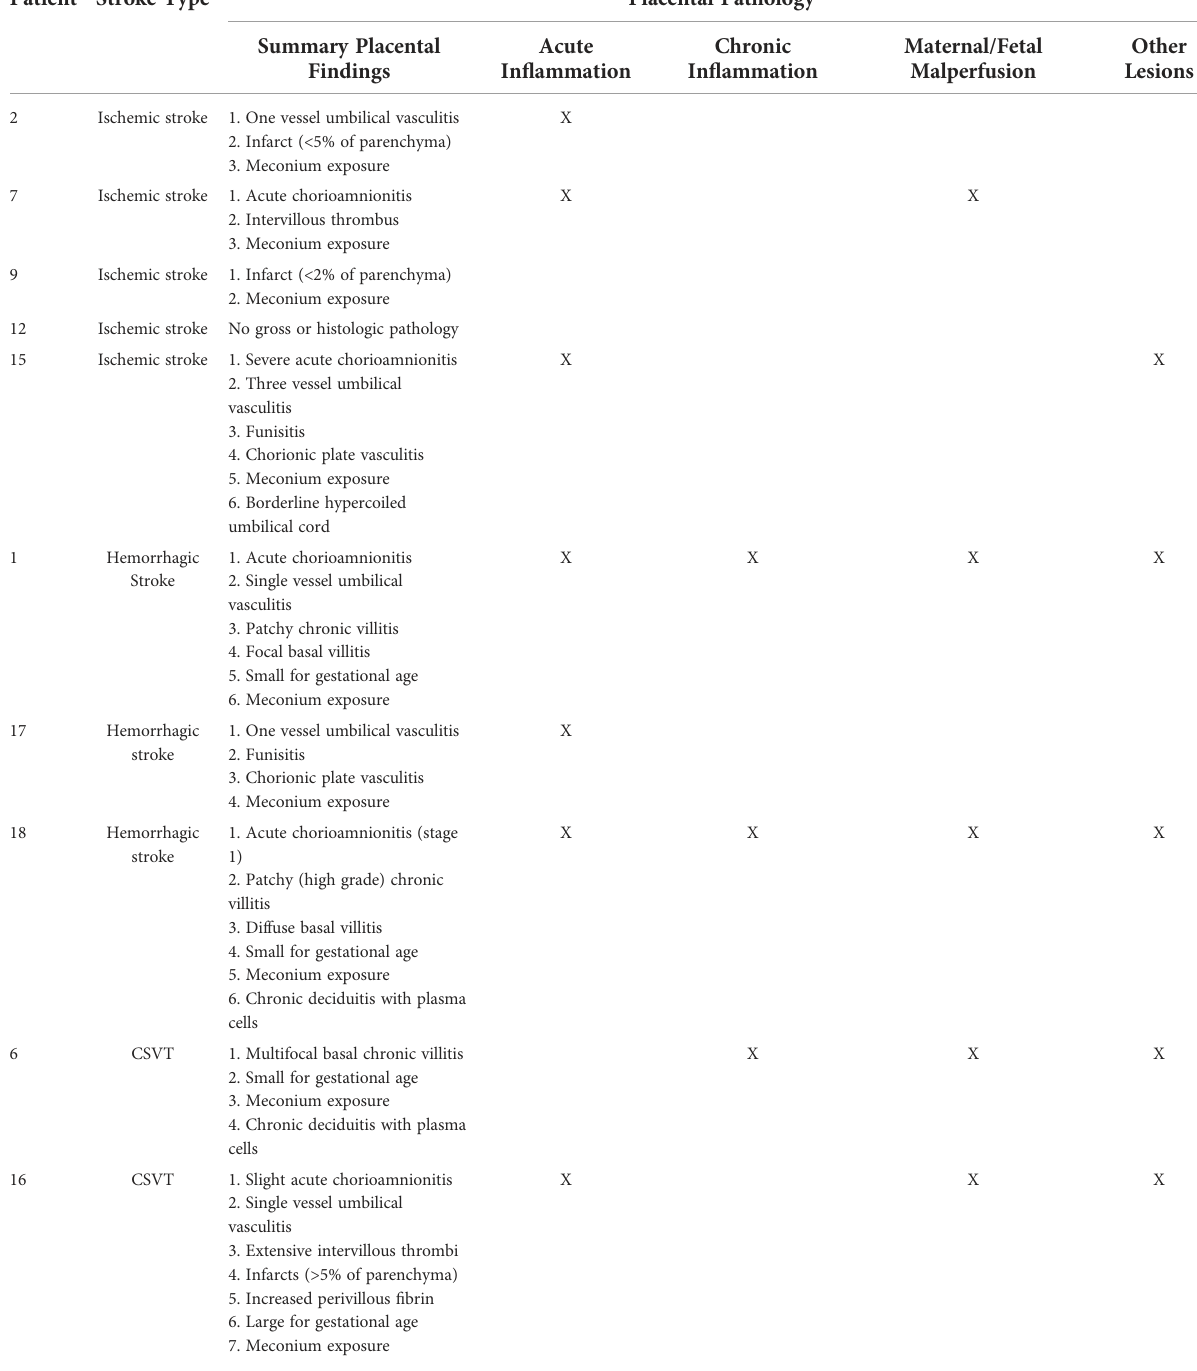
TABLE 4 Placental gross and histopathologic fi ndings. Patient Stroke